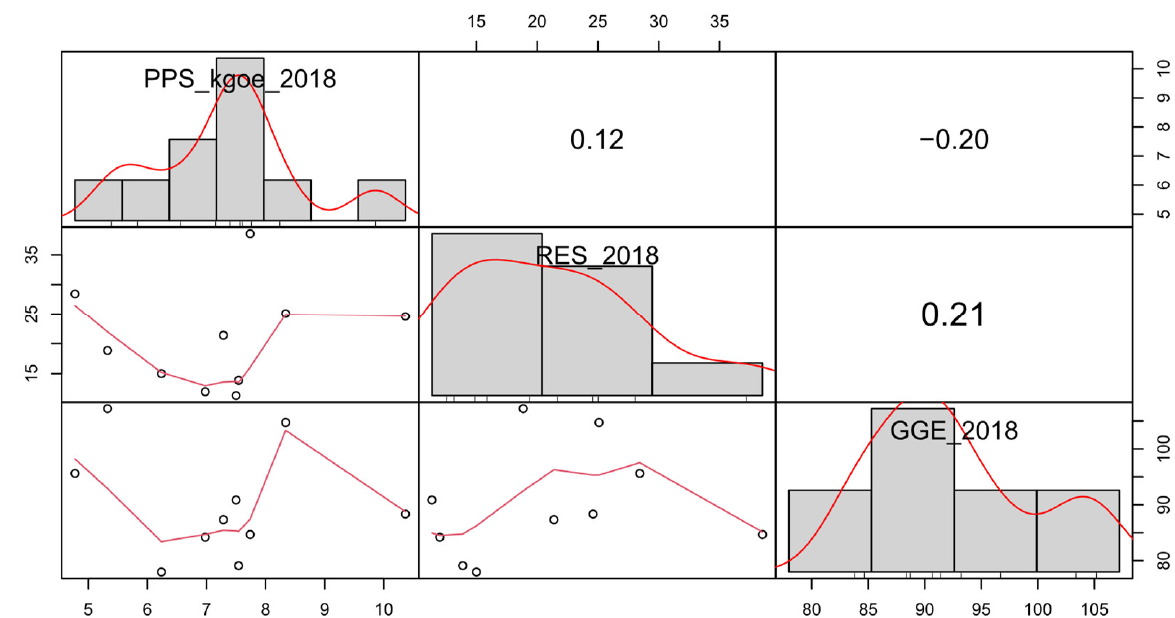
Figure 1. Pearson correlation coefficients between partial indicators purchasing power standard (PPS)/kgoe, renewable energy sources (RES), and greenhouse gas emissions (GGE) in 2018.